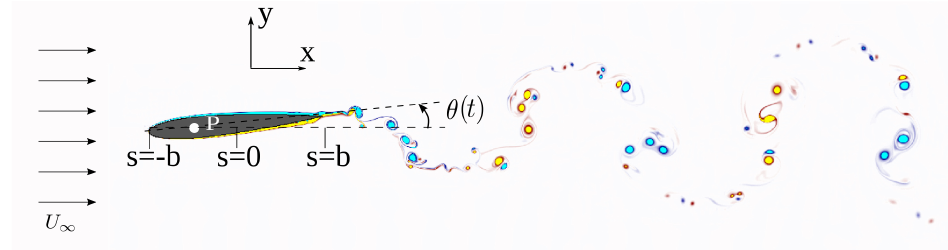
Figure 1. Schematic depicting the uniform flow past a foil that undergoes an oscillatory rotational pitch about the pivot point P . The foil’s angular position is indicated with θ ( t ) . The length coordinate s ranges from − b to b from the leading to the trailing edge of the foil, where b = c /2. The coloured contours illustrate the instantaneous vorticity distribution for a prototypical flow that ensues from the oscillatory motion of a foil pitched sinusoidally about its quarter chord with an angular amplitude θ 0 = 5 ◦ at a frequency that leads to Re = 10 5 and St = 0.1. Here, blue and yellow contours indicating negatively and positively signed vorticity